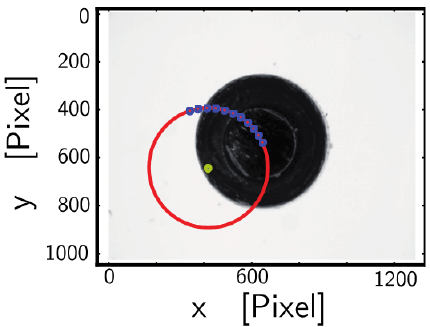
Fig. 7: A reference mark describes a circle while the camera system is rotated. The pivot point identifies the z axes of the TCP.